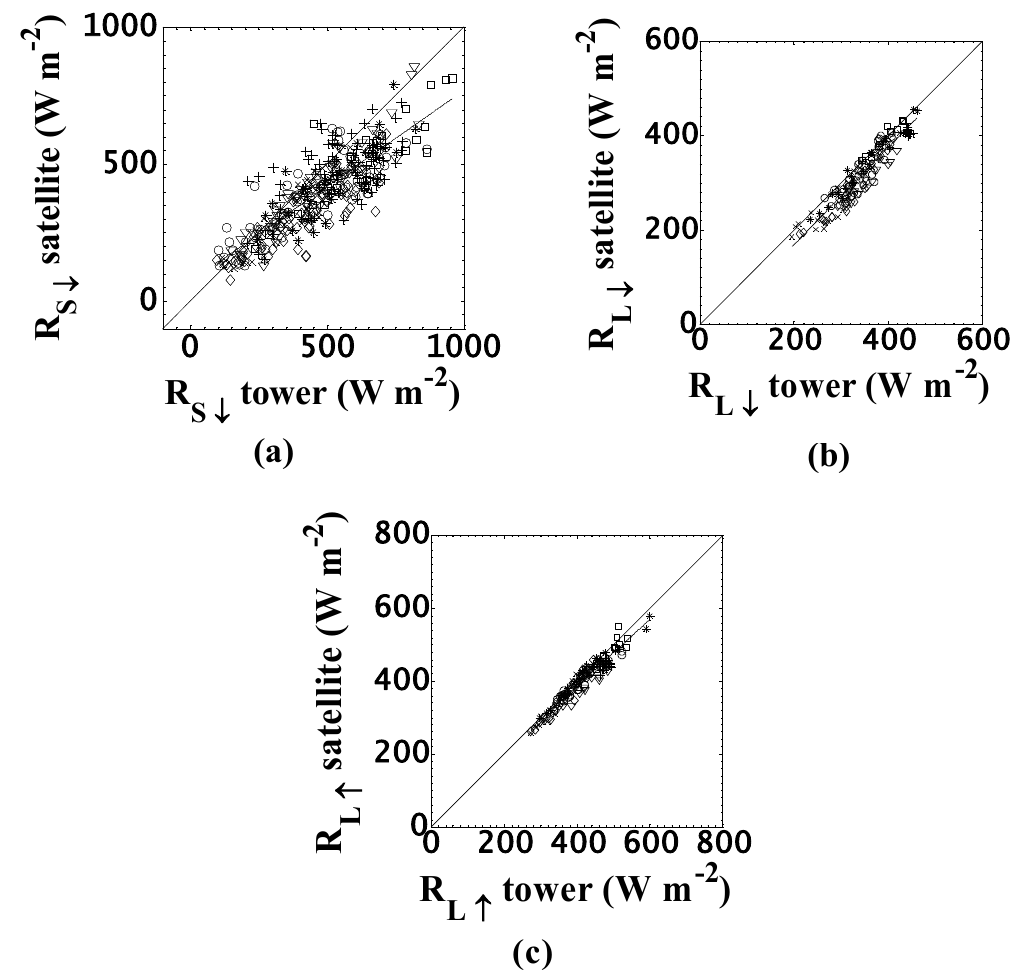
Figure 9. Comparison of satellite and tower monthly average 13:30LT (a) R S ↓ , (b) R L ↓ and (c) R L ↑ for a selection of sites for which tower data for R S ↓ (360 data points), R L ↓ (159 data points) and R L ↑ (159 data points) were available. The linear fit (solid line) between the two sources of R S ↓ is R S ↓ (AIRS) = 0.70 ( ± 0.02) R S ↓ (tower) + 67.68 ( ± 12.24); r = 0.84 ( ± 0.03). The linear fit (solid line) between the two sources of R L ↓ is R L ↓ (AIRS) = 1.03 ( ± 0.03) R L ↓ (tower)–36.91 ( ± 10.05); r = 0.95 ( ± 0.03). The linear fit (solid line) between the two sources of R L ↑ is R L ↑ (AIRS) = 0.91( ± 0.02) R L ↑ (tower) + 20.43 ( ± 8.77); r = 0.96 ( ± 0.02). The dashed lines are 1 : 1 in all